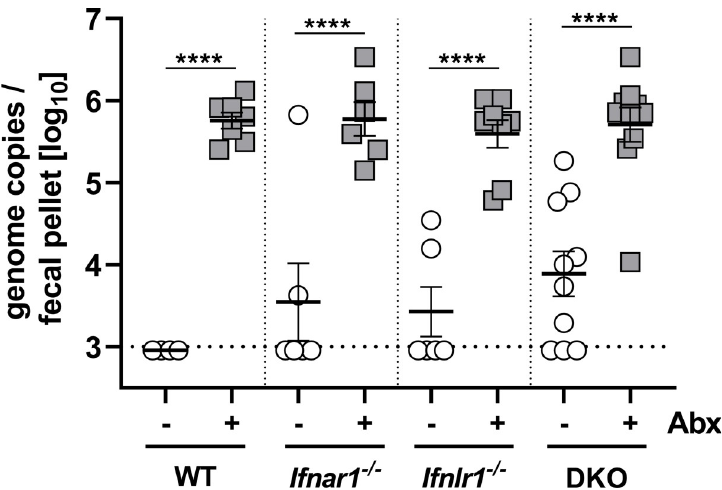
Fig 2. Rotavirus susceptibility of wild-type and IFN receptor-deficient C57BL/6 mice is greatly enhanced if the microbiome is depleted with antibiotics. WT (n = 7), Ifnar1 -/- (n = 6), Ifnlr1 -/- (n = 8) and Ifnar1 -/- Ifnlr1 -/- (DKO, n = 10) mice were left untreated or treated with antibiotics (Abx) before oral infection with 10 4 SD 50 of the EC strain of murine rotavirus. On day 5 post-infection, fecal pellets were collected and viral RNA levels were determined by RT- qPCR. Symbols represent individual mice, and bars represent means ± SEM. Line represents limit of detection of the RT-qPCR assay. Statistical analysis: Ordinary one-way ANOVA with Tukey’s multiple comparisons; ���� p < 0.0001.